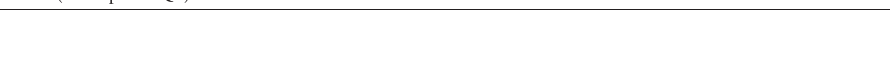
Table 2 Answers of the manufacturers about the divisibility of the 68 indexed scored tablets of the Hospital Drug Formulary whose SPCs (Summary of Product Characteris- tics) mentioned “divisible” or no information at all; answers concerned the possibility of splitting for facilitat- ed intake (Yes or No) or for fractional dosing (Yes or